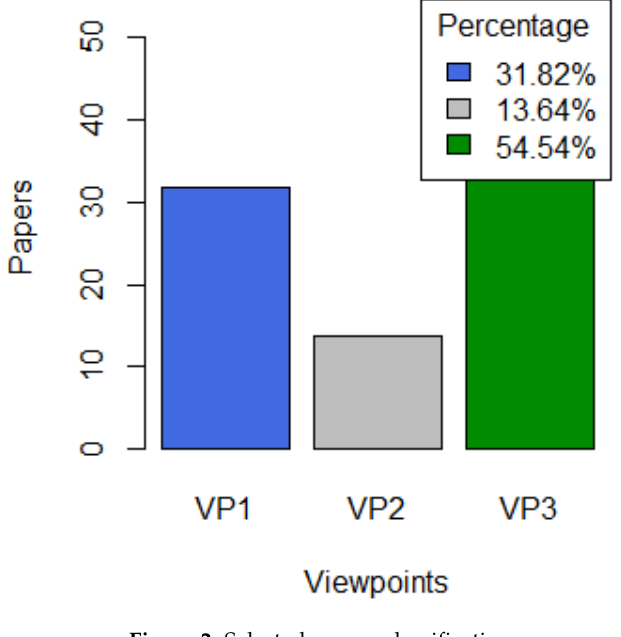
Figure 2. Selected papers classification.